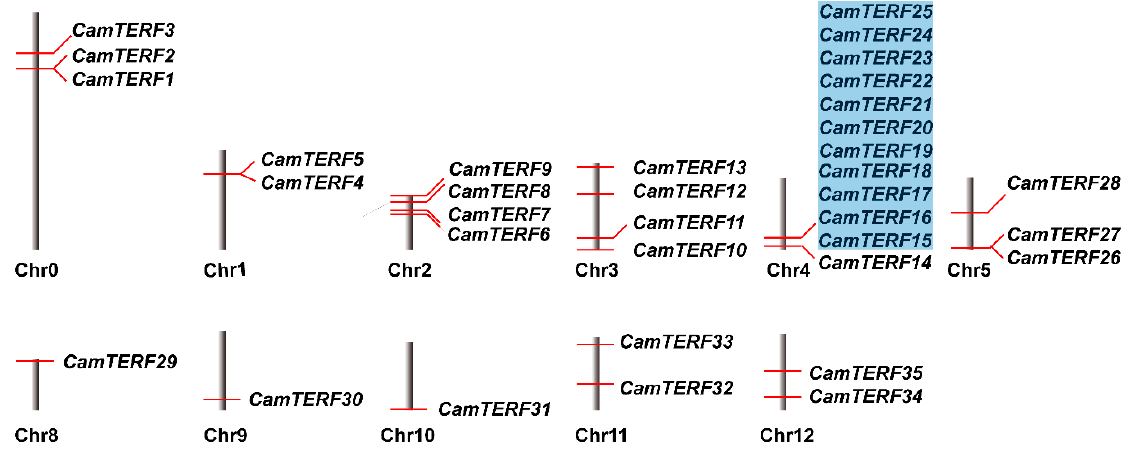
Figure 1. Chromosomal location and gene duplication of capsicum mTERFs ( CamTERFs ). The tandem duplicated genes are marked by blue rectangles.